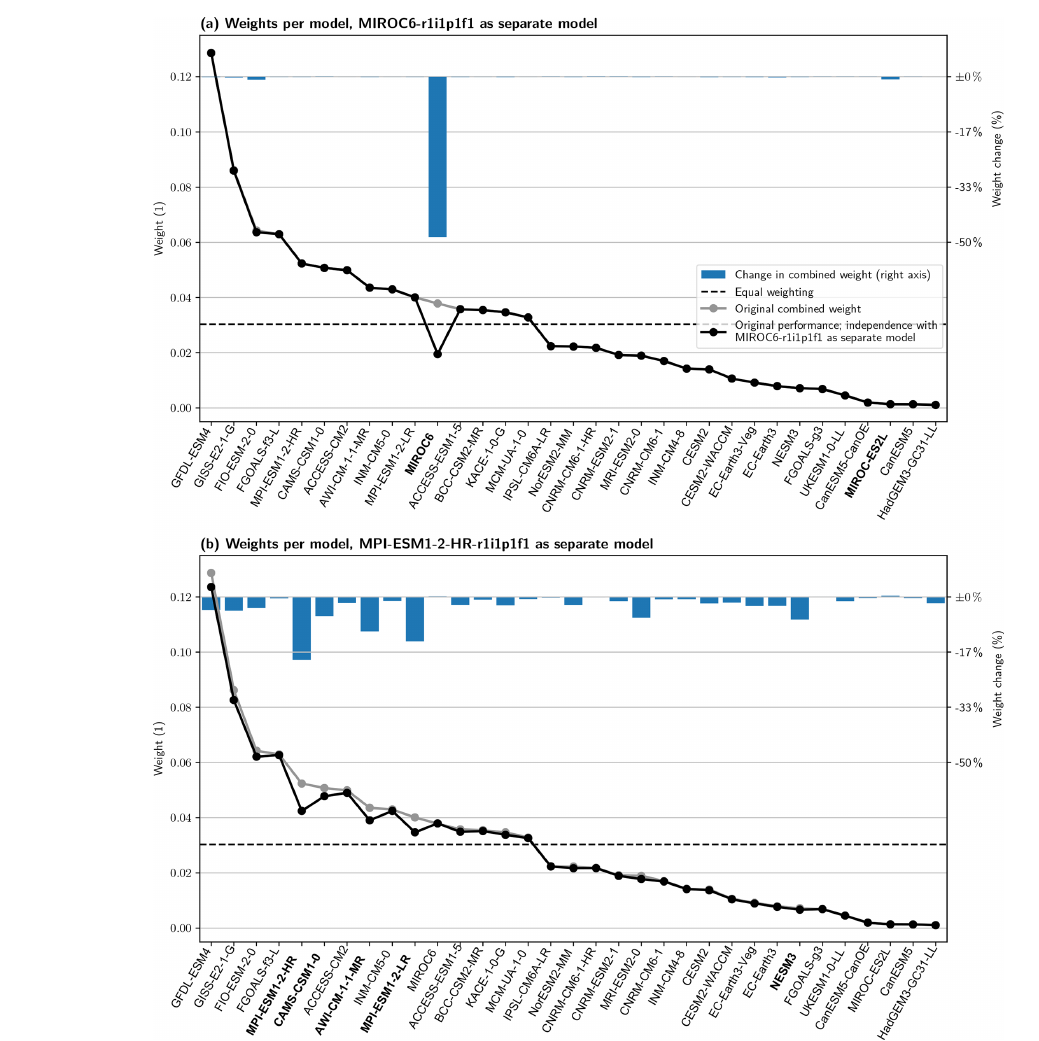
Figure 6. Similar to Fig. 4 but removing one initial-condition ensemble member from (a) MIROC6 and (b) MPI-ESM1-2-HR and adding it as a separate model when calculating the independence weights (the “new” model is not shown in the plot). Models with obvious dependencies on the “new” model have bold labels (equivalent to Fig. 5). The change in the combined weight relative to the original weight is shown as blue bars using the right